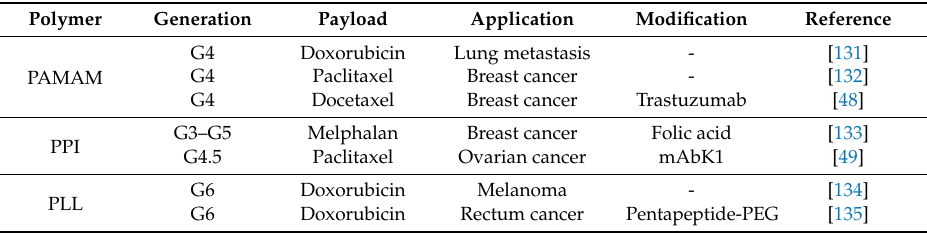
Table 3. Examples of dendrimer-based nanosystems as drug